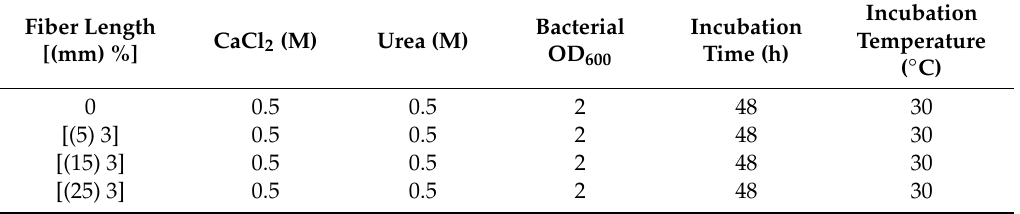
Table 3. Testing conditions for CaCO 3 precipitation with jute fibers